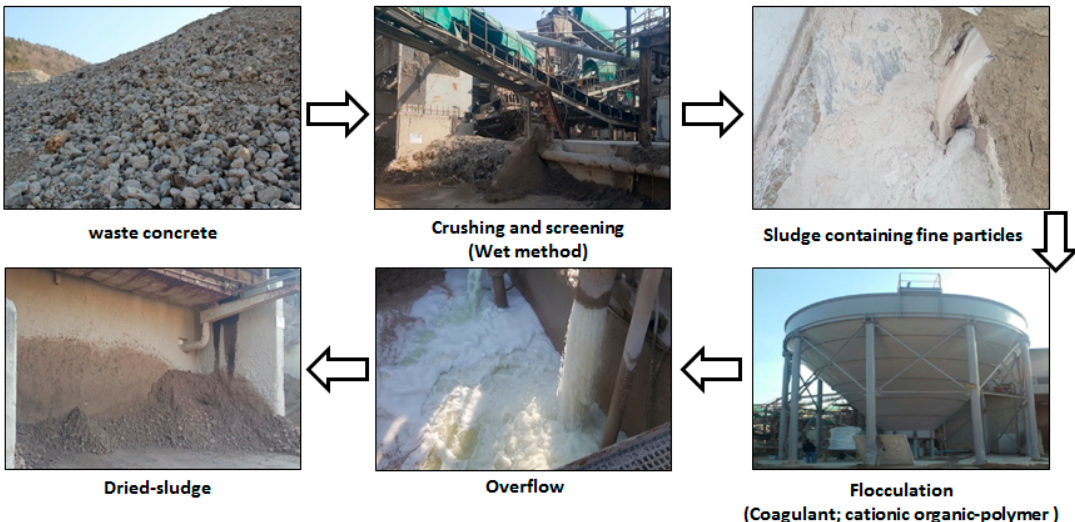
Figure 1. Photographs of a field waste concrete recycling process.